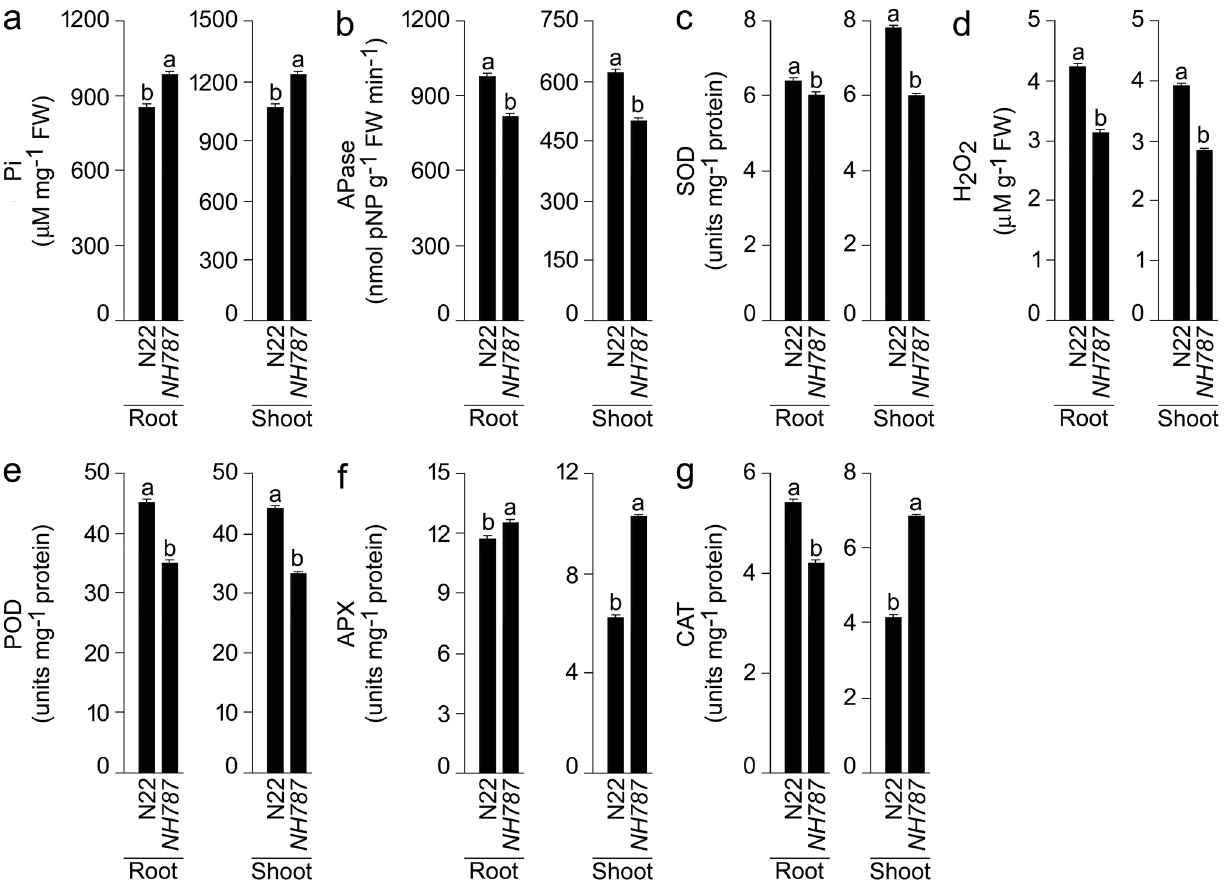
Figure 5. Effects of Pi deficiency on the concentrations of Pi, Apase, and the enzymes involved in ROS scavenging. N22 and NH787 were grown in a potting soil up to 50% flowering under P+ and P− conditions. ( a – g ) Data are presented for the concentrations of ( a ) Pi, ( b ) Apase, ( c ) SOD, ( d ) H 2 O 2 , ( e ) POD, ( f ) APX, and ( g ) CAT. Values ( n = 12) are means ± SE and different letters on the histograms indicate that the means differ significantly ( P < 0.05). Ps potting